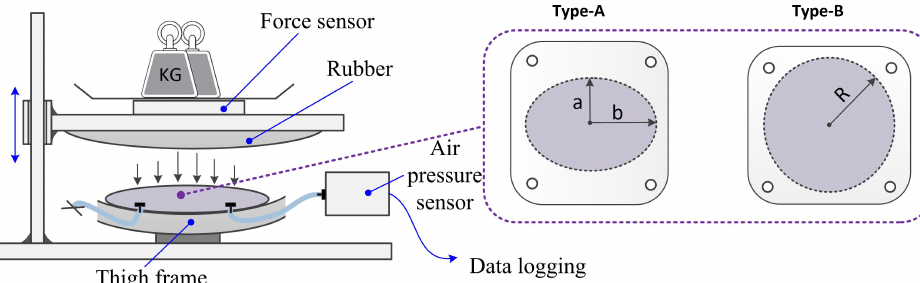
Figure 5. Schematic diagram of soft chamber characteristics test ( left ) and design of different shapes of air chambers ( right ). Geometric parameter: a = 23 mm, b = 30 mm, R = 60 mm.